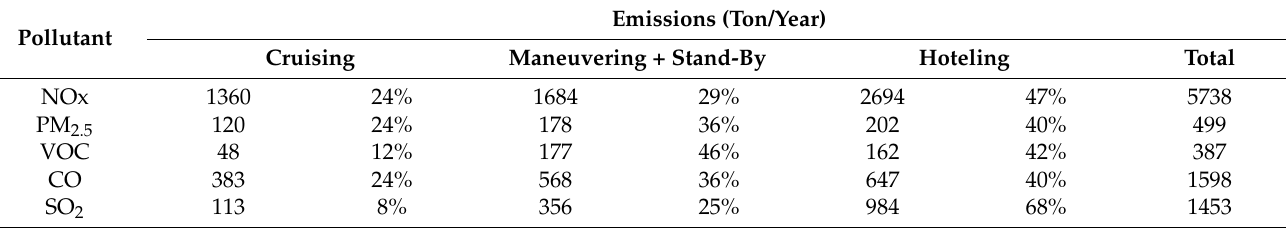
Table A13. Total emissions from vessels (Haifa, MPS 2025).